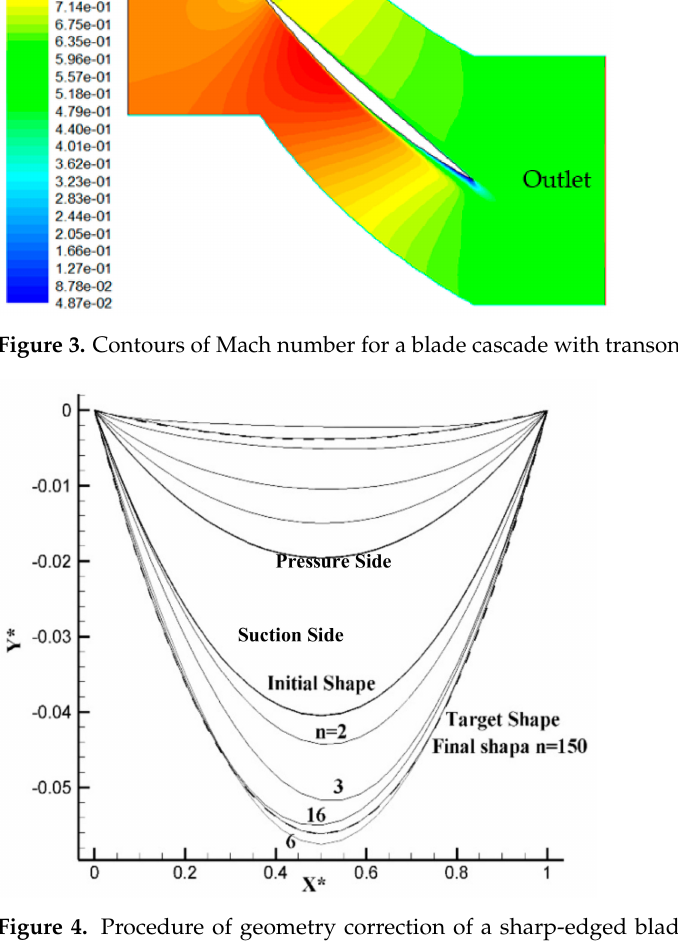
Figure 4. Procedure of geometry correction of a sharp-edged blade cascade (shown in the non- dimensionalized coordinates of X* and Y*), in the original UESA in transonic flow regime (Mach inlet =